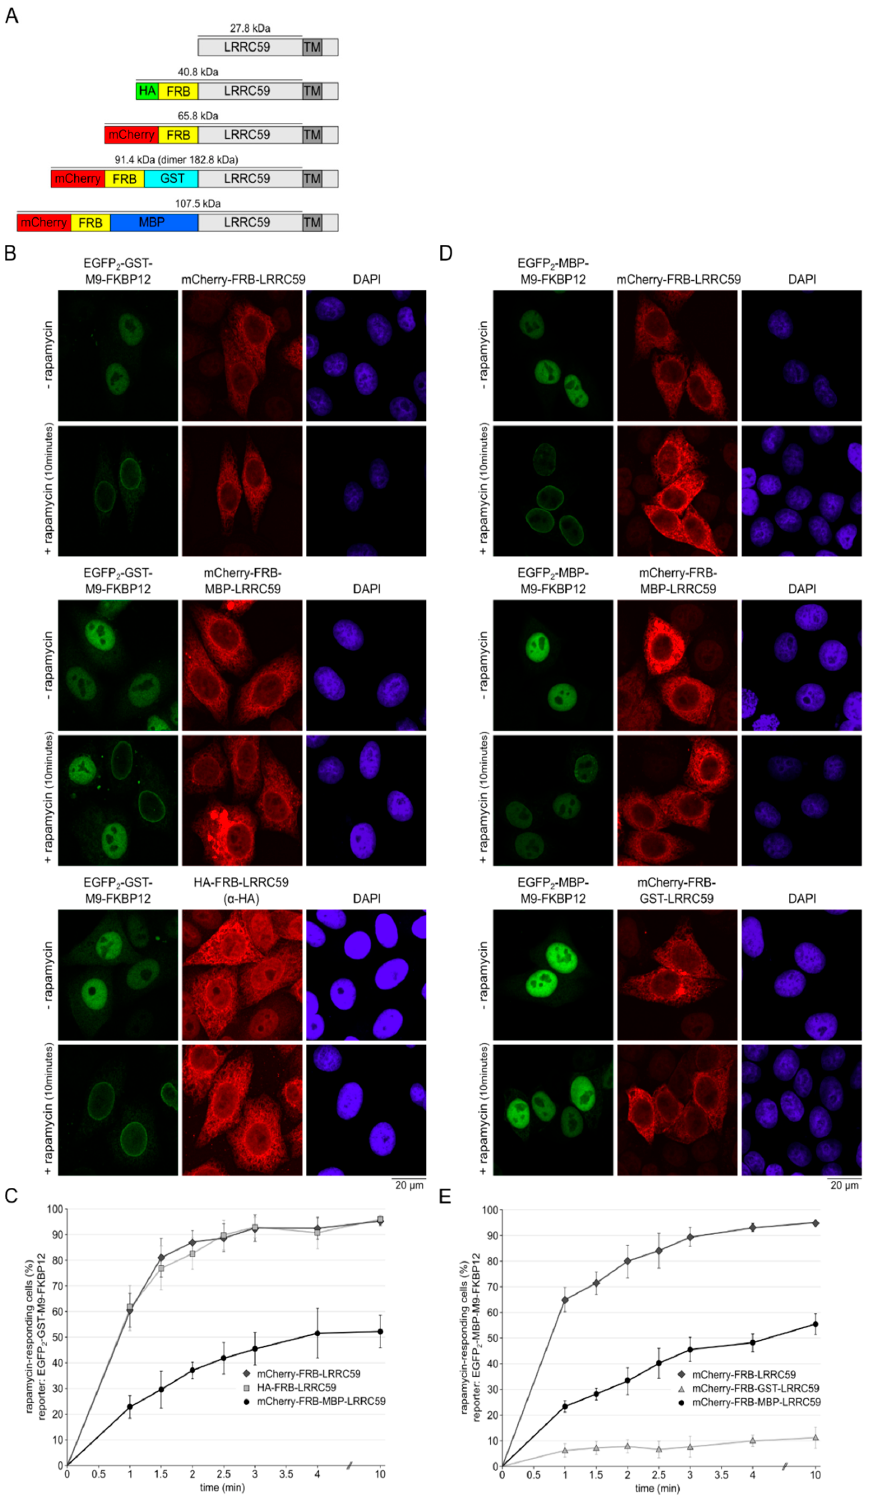
Figure 6. The size of the cytoplasmic domain of LRRC59 affects its targeting to the INM. ( A ) Schematic overview of LRRC59-constructs of different sizes. ( B ) HeLa cells were co-transfected with plasmids coding for EGFP 2 -GST-M9-FKBP12 and mCherry-FRB-LRRC59, mCherry-FRB-MBP-LRRC59 or HA-FRB-LRRC59, respectively. Plasmid concentrations were adjusted for similar expression levels of the different LRRC59 forms. After 48 h, cells were treated with or without rapamycin for 1–10 min,